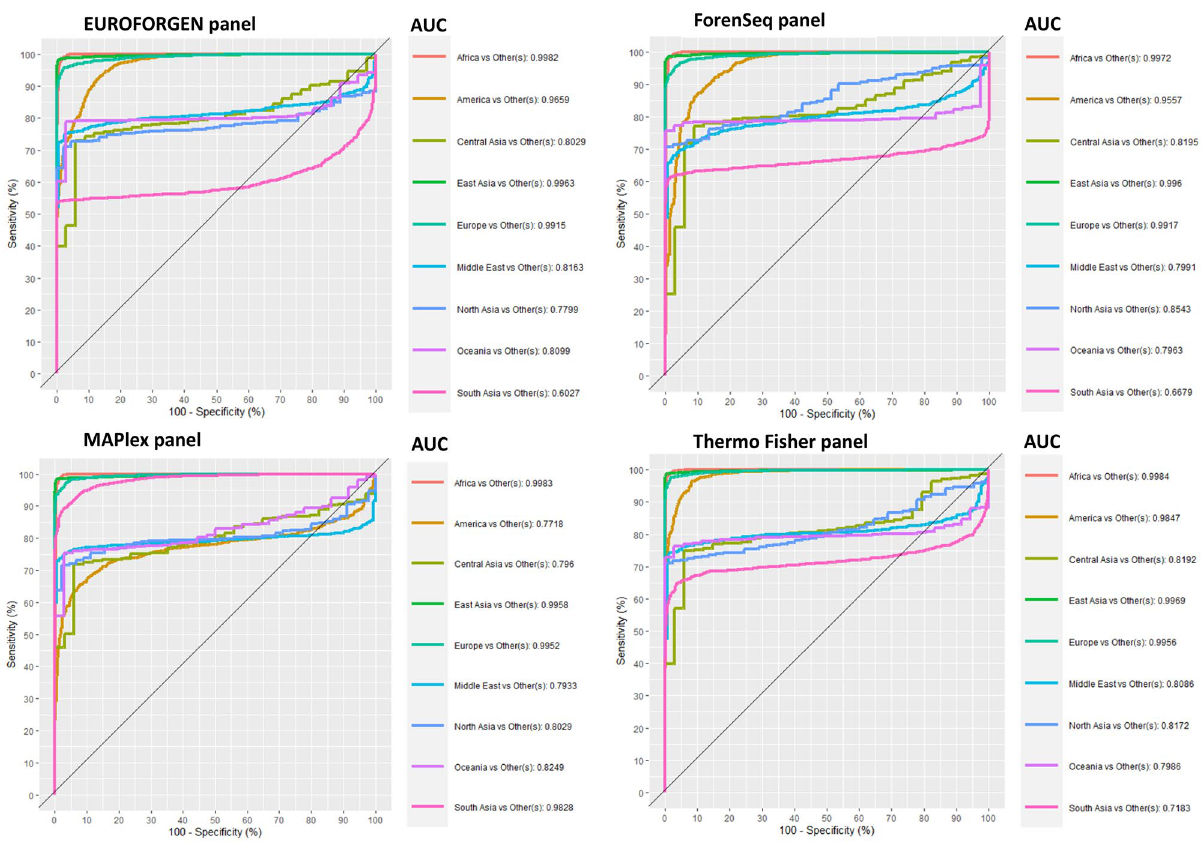
Figure 3. ROC curves, sensitivity, specificity, and AUC values for the tested continental